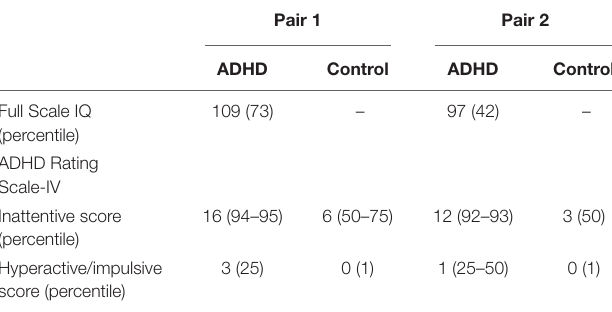
TABLE 1 | Clinical status between monozygotic twin discordant